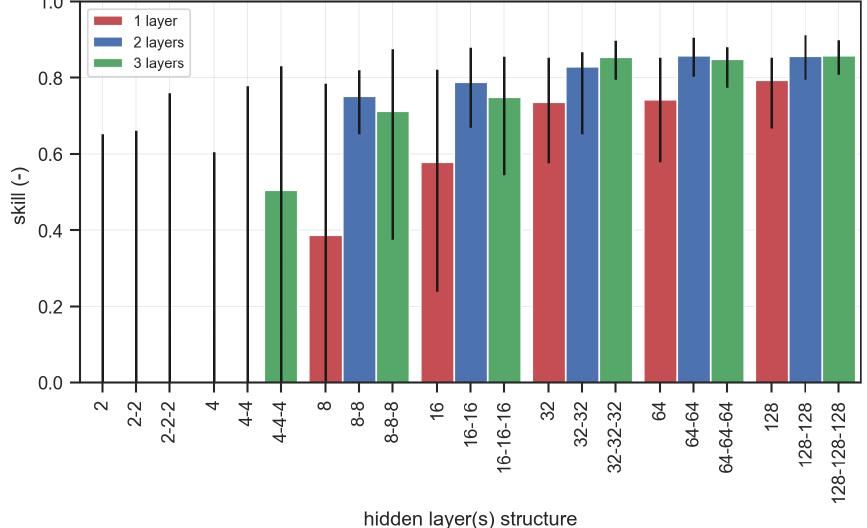
Figure 8. Skill of the DEV prediction for the calibration cases using different configurations of the regression ANN with a different number of hidden layers and nodes per layer. On the x axis the architecture of each ANN is represented by the number of neurons per layer, with layers separated by “–”. The bars indicate the mean values between the 10 randomizations of the benchmark dataset, and the lines show the min and max values. The lower limit of the y axis has been set to 0 to avoid visualization issues when skill was negative for some configurations with low number of layers and nodes. Table 2. Cases used for the validation of the meta-model